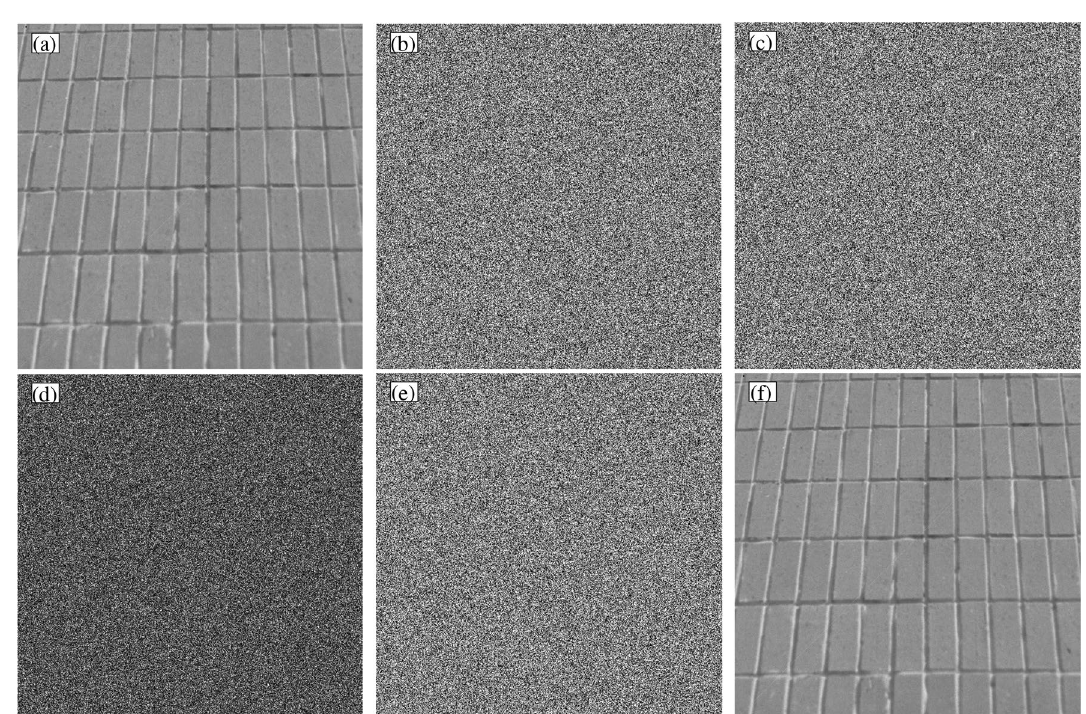
Figure 15. Key sensitivity test results. ( a ) Plaintext. ( b ) Ciphertext under K a . ( c ) Cipher text under K b . ( d ) The ciphertext difference between K a and K b . ( e ) Decryption under K b . ( f ) Decryption under K a